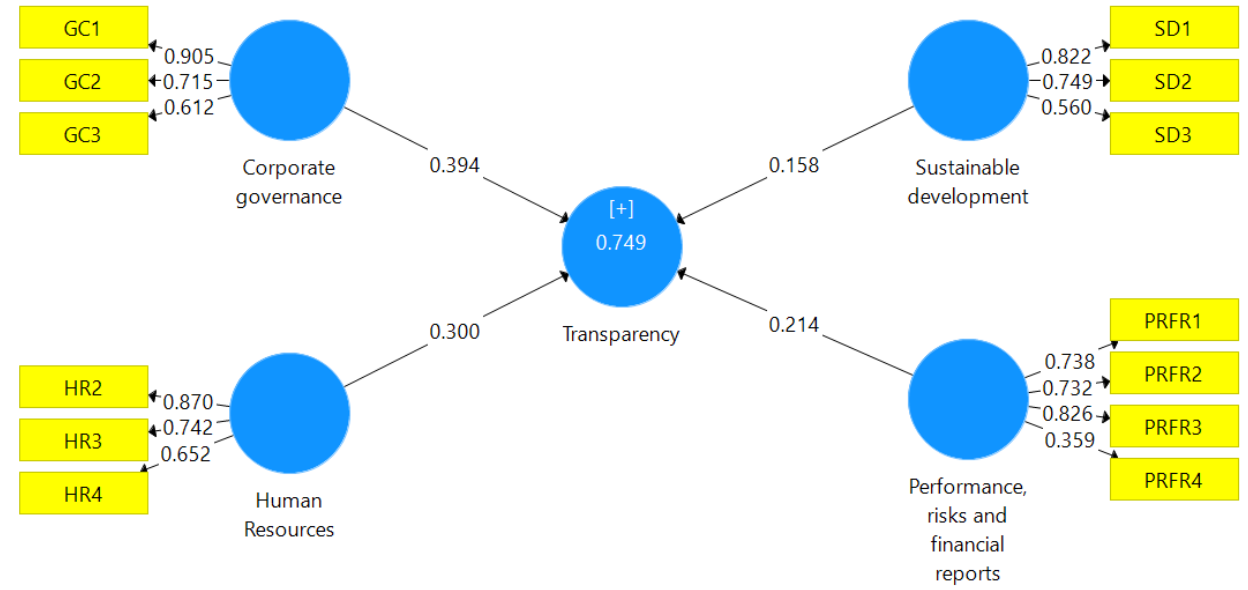
Figure 1. Structural model. Source: Authors’ calculation with SmartPLS (v. 3.3.3) software. The constructs (listed using Roman numerals) that define company transparency and the observable variables (listed using Arabic numerals) corresponding to each construct are shown in Table 1.